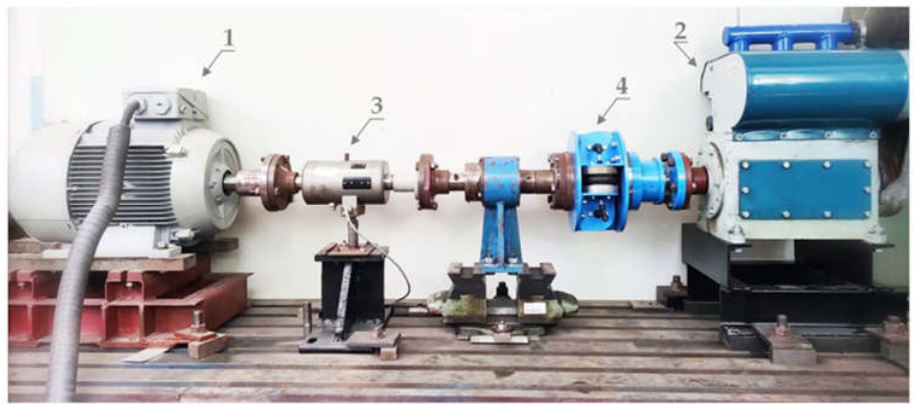
Figure 10. Mechanical drive with a piston compressor: Variable speed electric motor (1), variable operating speed compressor (2), torque sensor (3), pneumatic tuner